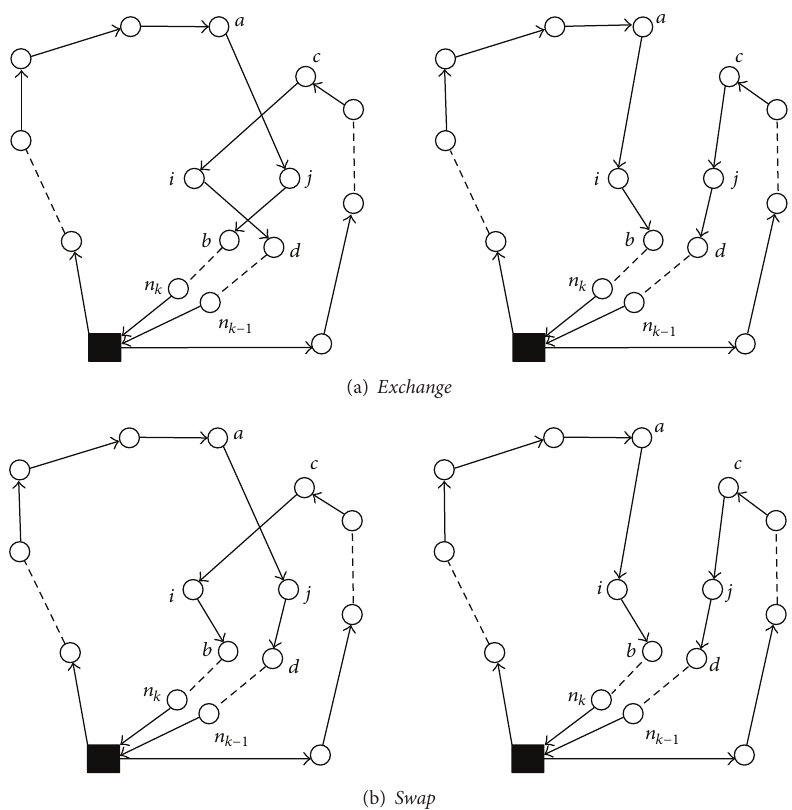
Figure 4: The exchange and swap operations.